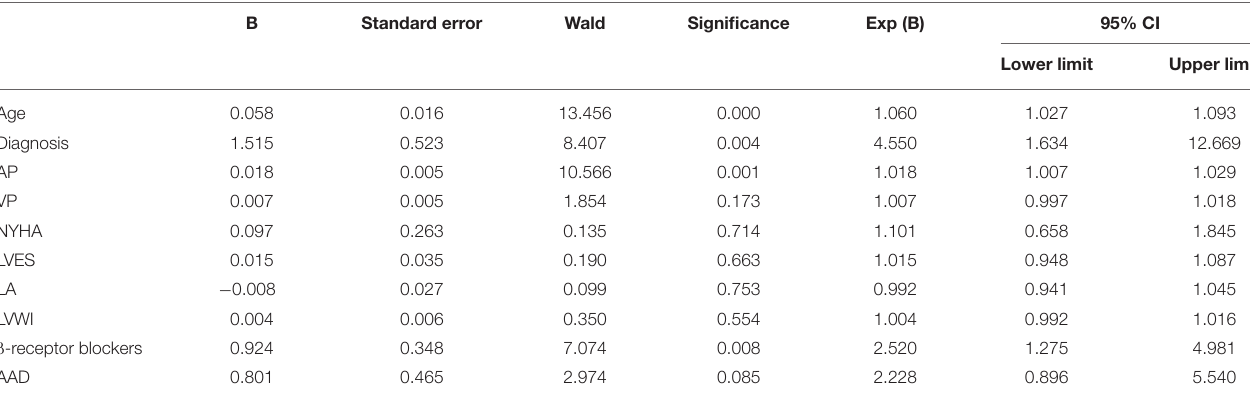
TABLE 4 | Binary multivariate logistic regression analysis of